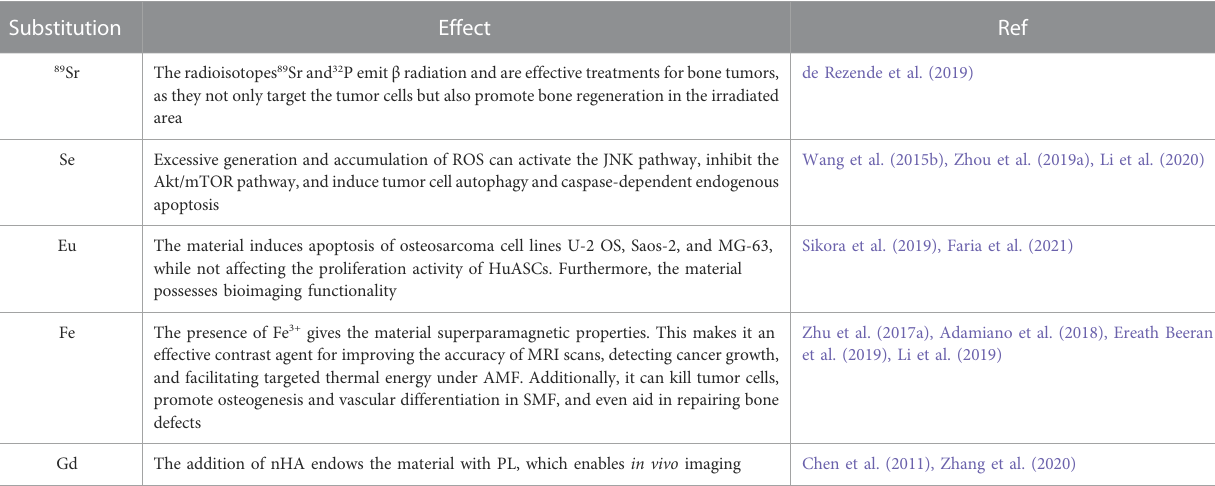
TABLE 3 Ionic exchange/doping in the nHAp structure, useful for bone tumor therapy and diagnostics. Substitution